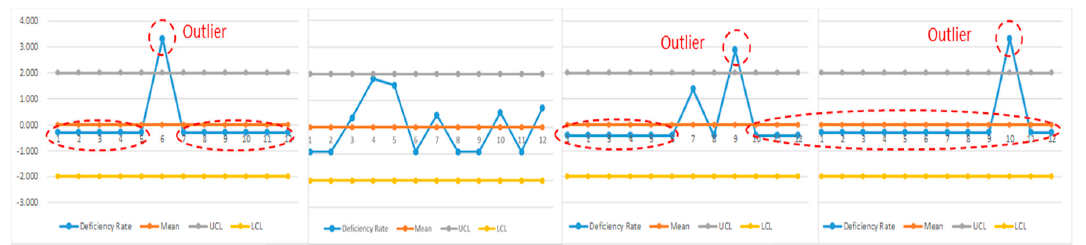
Figure 14. The control chart for deficiency 12 (2015–2018).